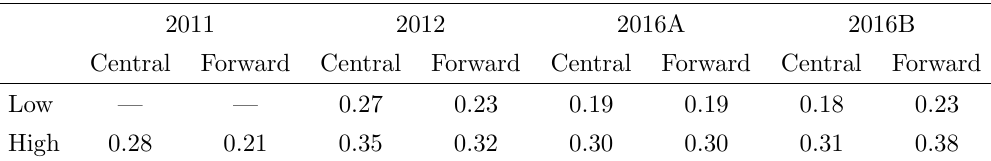
Table 1 . Analysis BDT discriminator boundaries per category, channel, and running period for the branching fraction determination (2011 has only one category because of the small sample